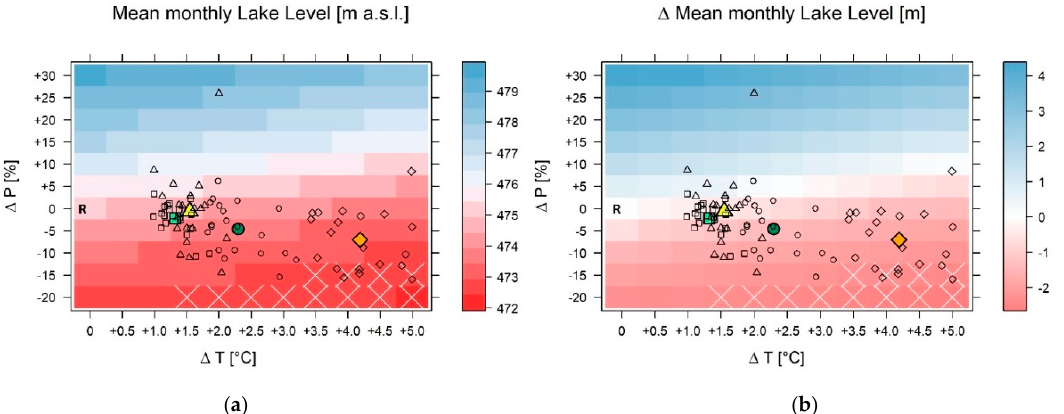
Figure 8. Response surfaces showing absolute (in m a.s.l., left ) and relative (deviation from reference level, right ) changes in the water level of Lake Malawi as simulated by the ULMBM and the LMM using systematically perturbed precipitation (y-axis) and temperature (x-axis) data as input. The points added to the response surface indicate the hydro-climatological change as projected by the 20 GCM–RCM combinations indicated in Table 2. The different symbols refer to different periods and scenarios (rectangles/circles: RCP4.5 near/far future; triangles/diamonds: RCP8.5 near/far future). The colored symbols reflect the mean of the climate model ensemble for the respective periods and scenarios (same color code as in Figure 7). Pixels marked by an “X” indicate combinations of Δ T and Δ P where outflow from Lake Malawi temporally ceases (i.e., lake level temporally falls below 470.8 m a.s.l.). R is the reference pixel ( Δ T = 0; Δ P = 0). The response surfaces demonstrate that the estimates for mean lake level range between 472.4